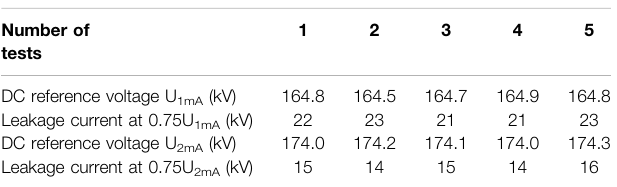
TABLE 4 | Test results of the